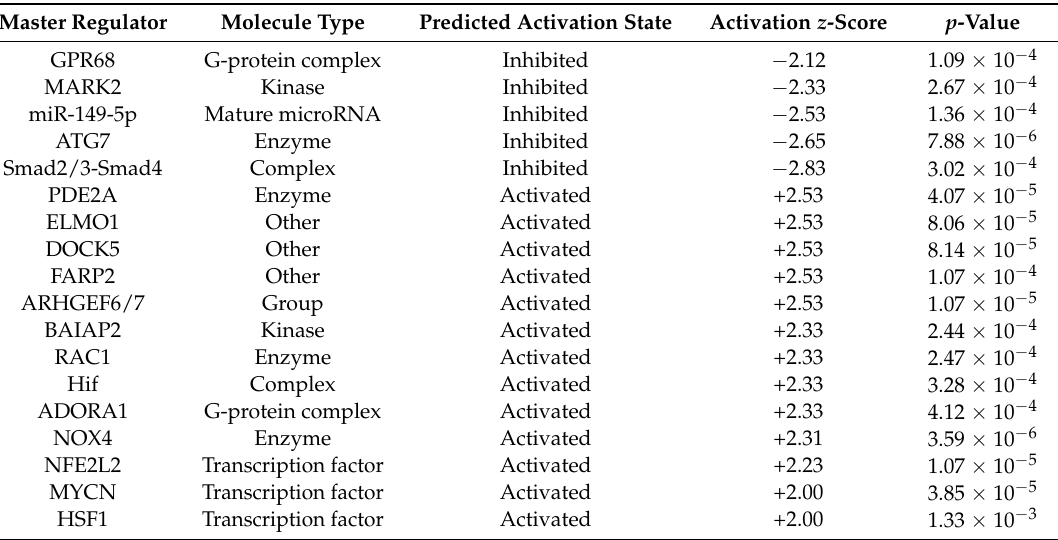
Table 4. Master regulators predicted by IPA